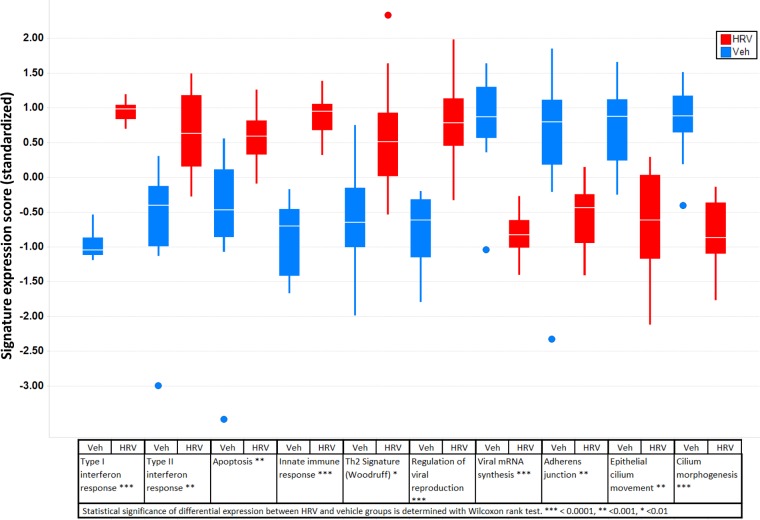
Functional pathways that showed statistically significant differential expression between RV-A16 and Vehicle groups (p<0.05).Outliner is shown individually with a solid circle.